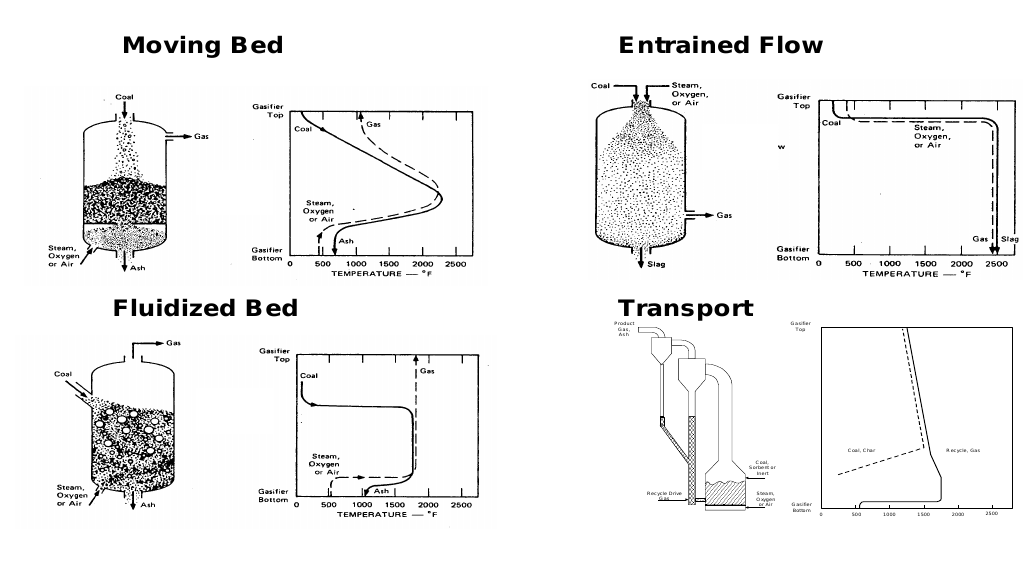
Figure 18. Gasifier Configurations [1].